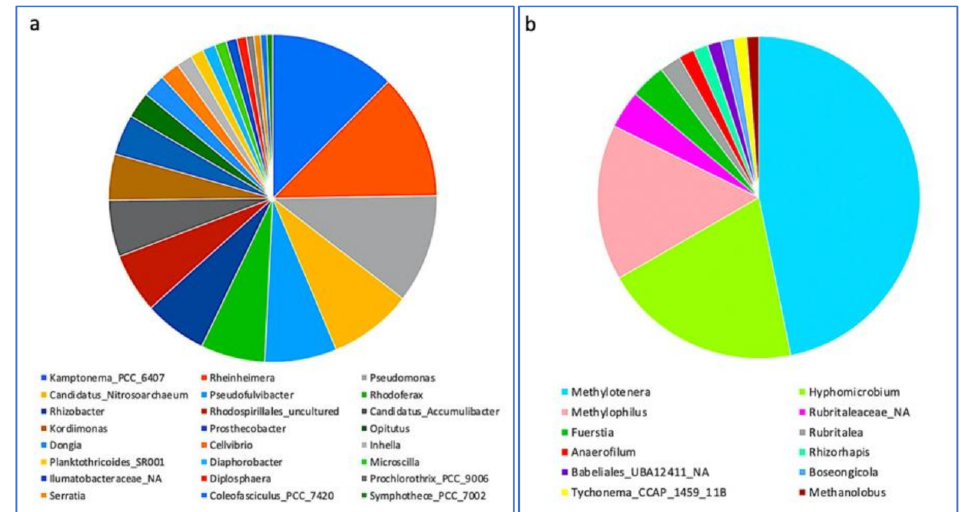
Figure 7. Relative abundance of the specialist genera in plant root bed substrate samples: ( a ) in control CWs and ( b ) in doped CWs collected at the end of the experiment (after 8 weeks). Systems irrigated along eight weeks with Ribeira de Joane water not doped (control) or doped with NP and OP. Only genera with abundance > 1% are